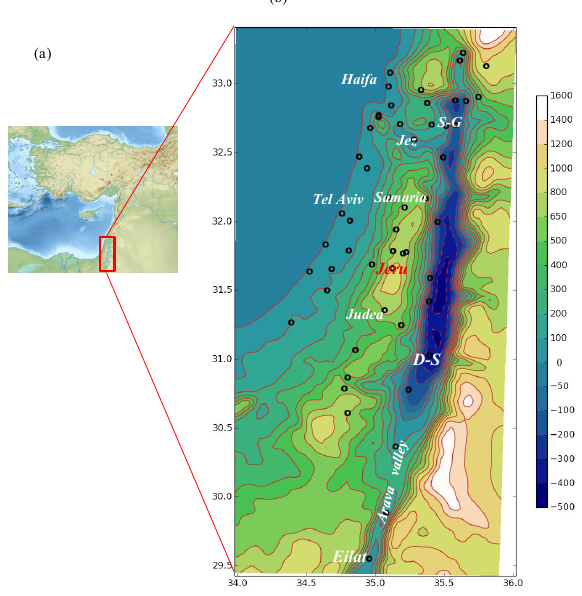
Figure 1. The East Mediterranean region (a) and the studied area (b) showing Jerusalem (Jeru), the Dead Sea (D-S), the Sea of Galilee (S-G), Jezreel valley (Jez). The locations of the 53 IMS stations are denoted by circles. The topography height above sea level [m] is denoted by colors and contour